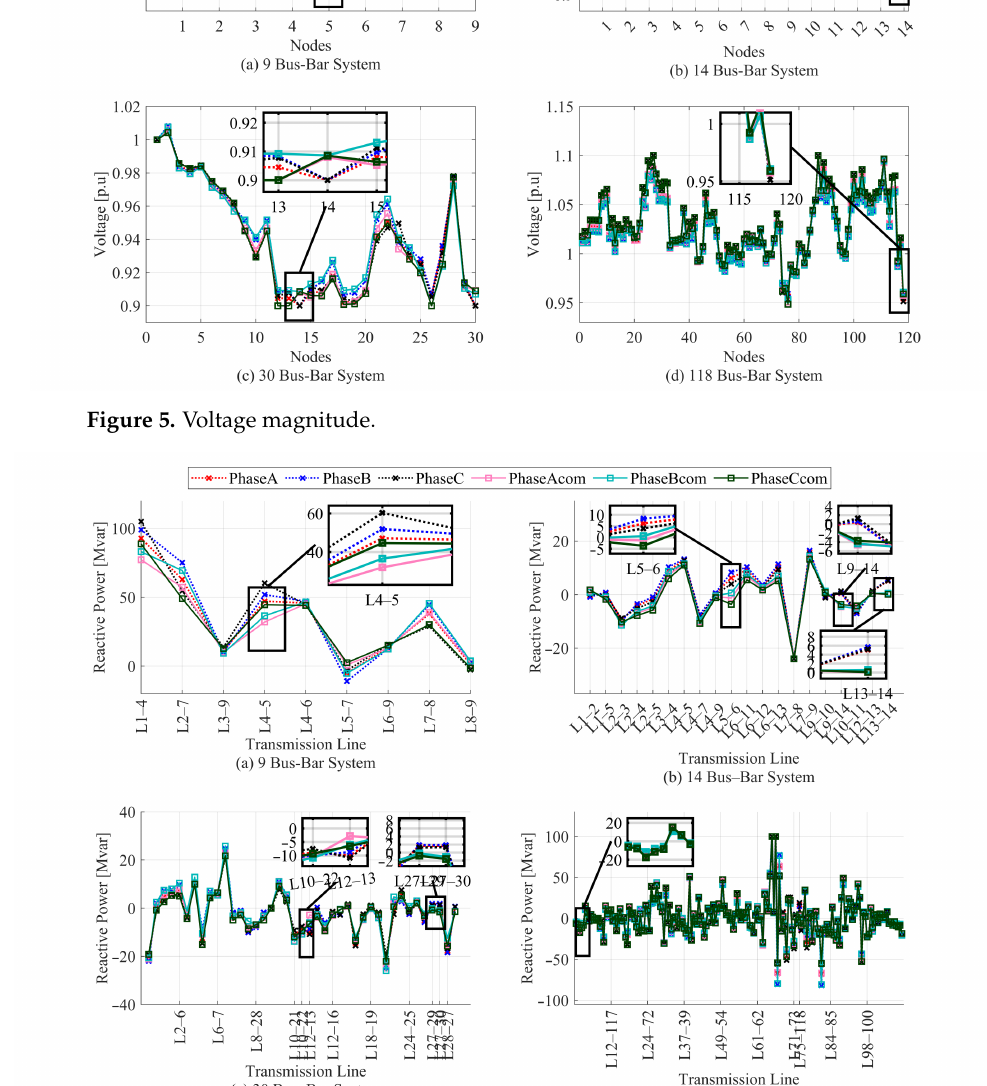
Figure 6. Transmission lines’ reactive